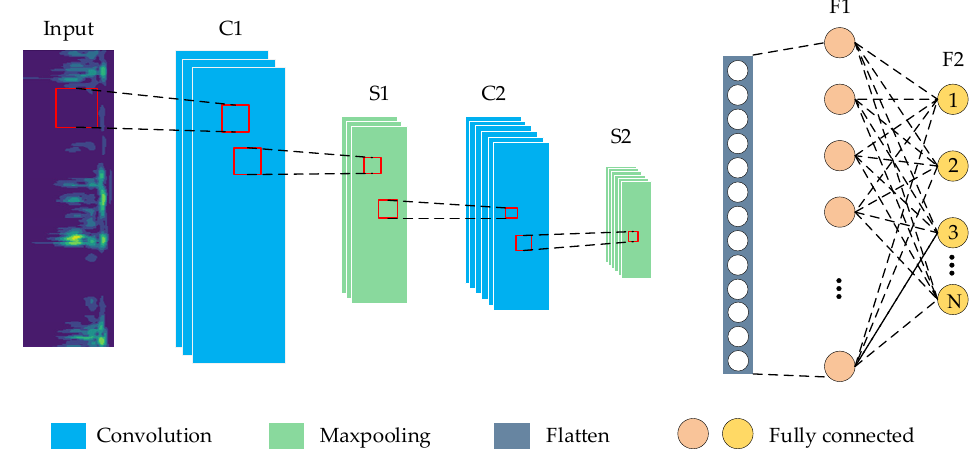
Figure 3. The architecture of LeNet-5-based CNN. It mainly contains two multiple convolutional, two pooling layers, and two fully connected layers. The time-frequency images are input to the first convolutional layer, and the classification of the output layer is achieved by the softmax function.